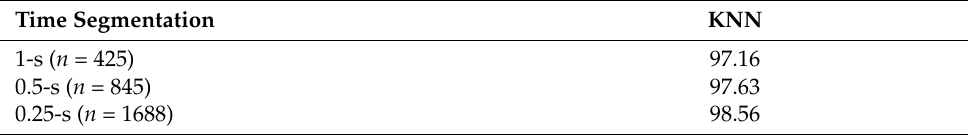
Table 6. Classification testing accuracy (%) for KNN with K = 5.